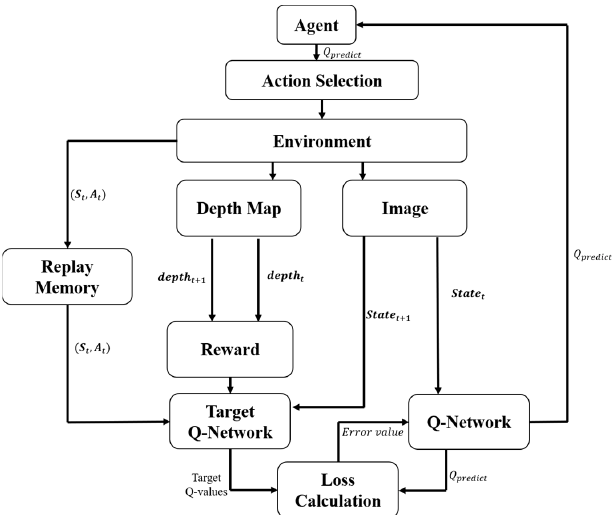
Figure 21. DQL obstacle avoidance flow chart.